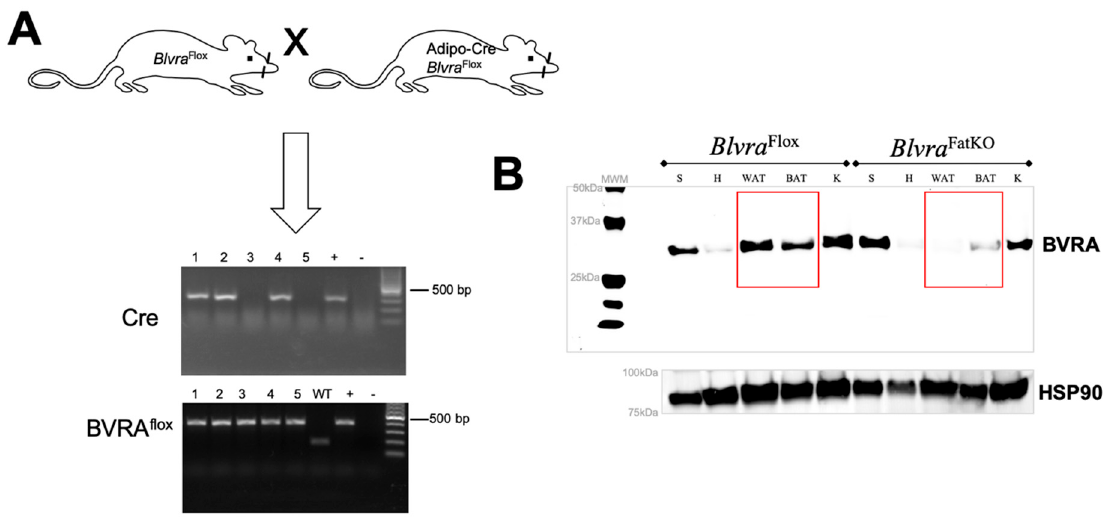
Figure 1. Adipose-specific knockout of biliverdin reductase-A (BVRA) in mice. ( A ) Homozygous floxed BVRA ( Blvra Flox ) mice were crossed to mice expressing the Cre recombinase specifically in adipose under the control of the adiponectin promoter to create adipose-specific BVRA knockout mice ( Blvra FatKO ). ( B ) Western blot for biliverdin reductase-A (BVRA) and heat shock protein 90 (HSP90) as a loading control in various tissues from Blvra Flox and Blvra FatKO mice. WAT, white adipose tissue. BAT, brown adipose tissue.